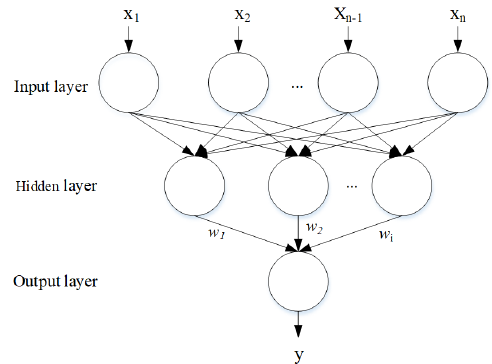
Fig. 1 RBF neural network. RBF, radial basis